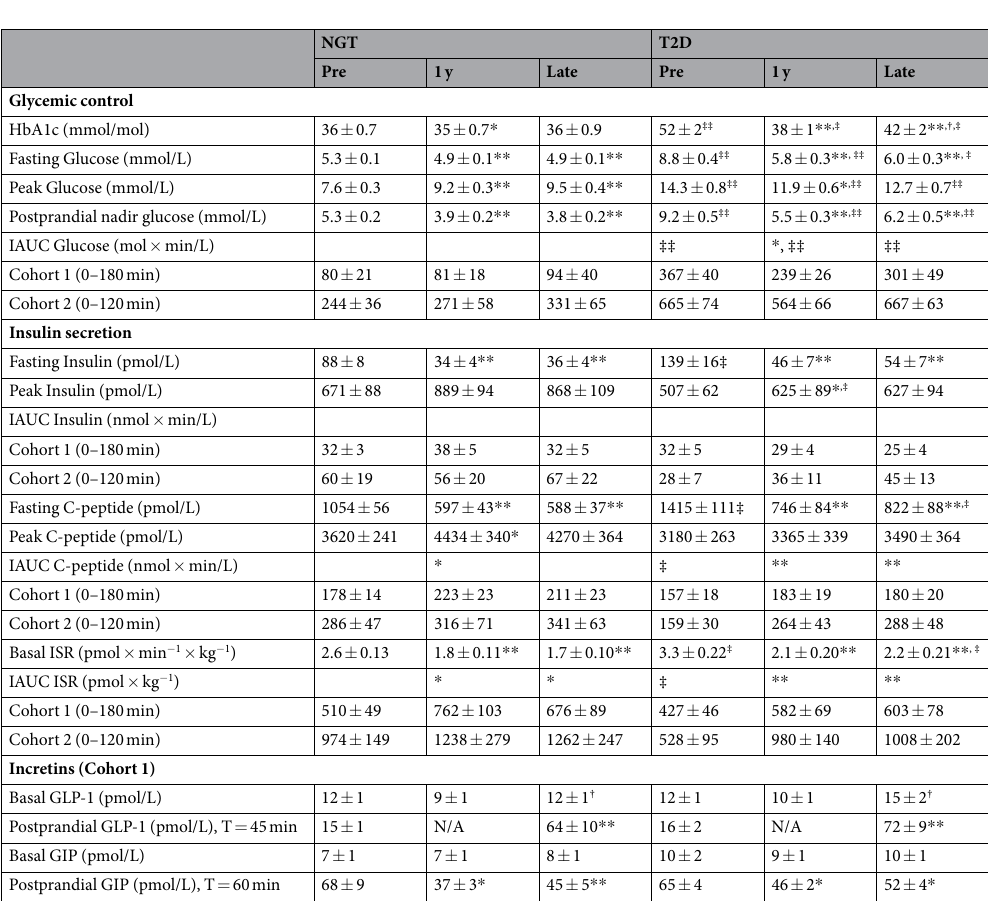
Table 4. Glycemic control, insulin and incretin secretion. * p < 0.05 vs pre, ** p < 0.001 vs pre; † p < 0.05 vs 1 y, †† p < 0.001 vs 1 y; ‡ p < 0.05 vs NGT , ‡‡ p < 0.001 vs NGT at corresponding time